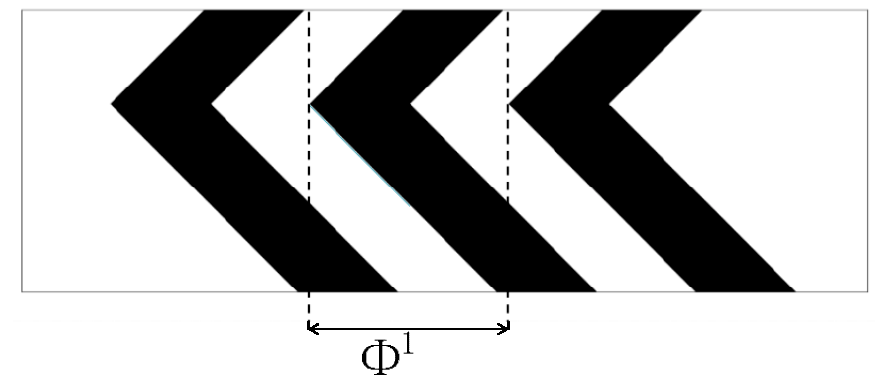
Figure 2. Schematic representation of the grooves in a staggered herringbone mixer (SHM). The mapping matrix Φ 1 covers a single groove applying a fully developed velocity field.